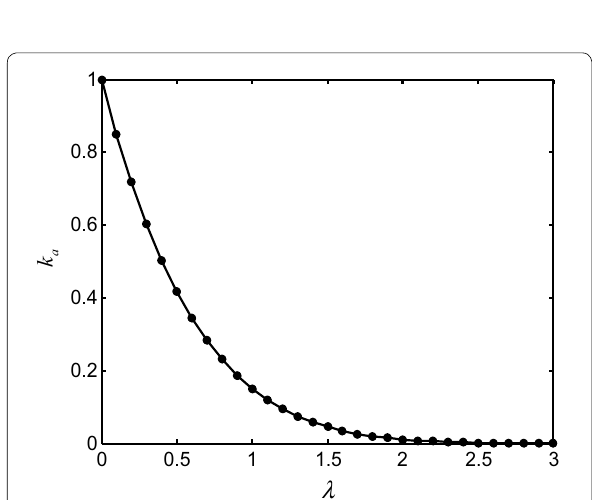
Figure 13 Variation of contact area ratio with film thickness ratio